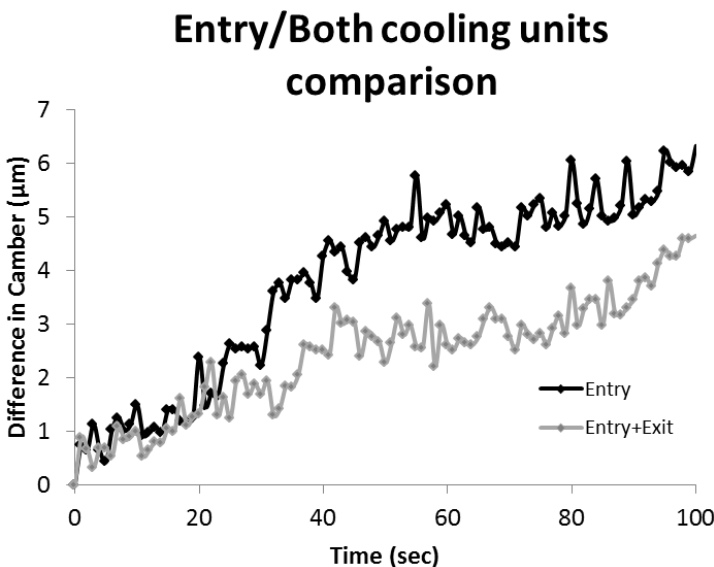
Figure 8. Comparison of camber evolution between entry cooling applied and entry and exit cooling applied simultaneously.